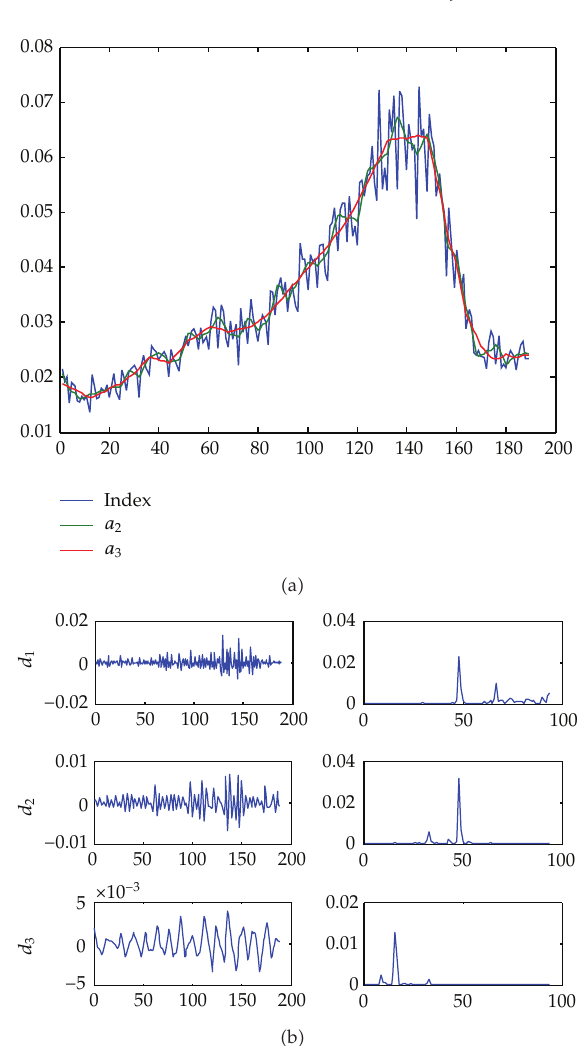
Figure 1: (cid:5) a (cid:6) db3 filter of Spain INDEX, (cid:5) b (cid:6) detail series and FFT of Spain